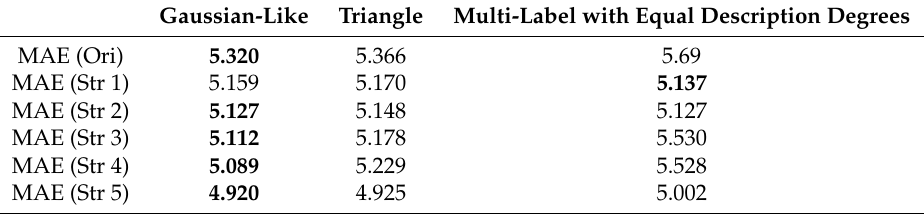
Table 10. MAEs of the compared three different patterns in generating age label distribution (the controlled variables in each pattern are traversed within the whole given range and best results are reported; for every row in the table, the optimal MAEs are marked in bold). Gaussian-Like